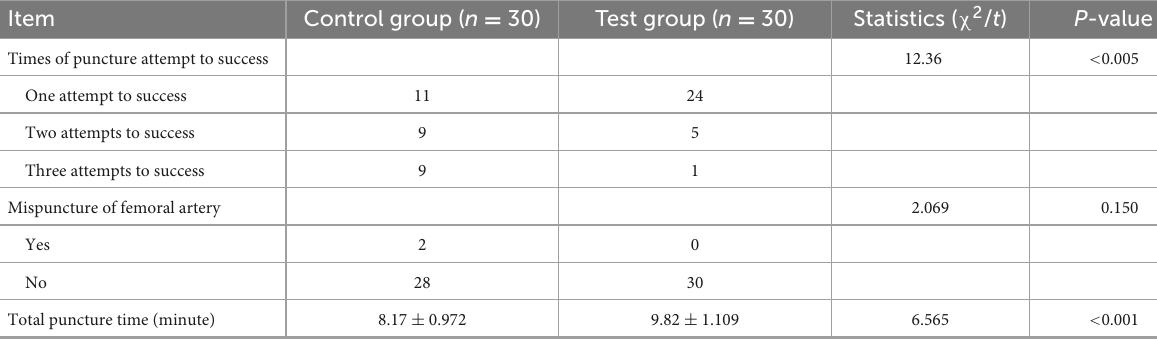
TABLE 3 Comparison of puncture results of resident doctors between two groups.